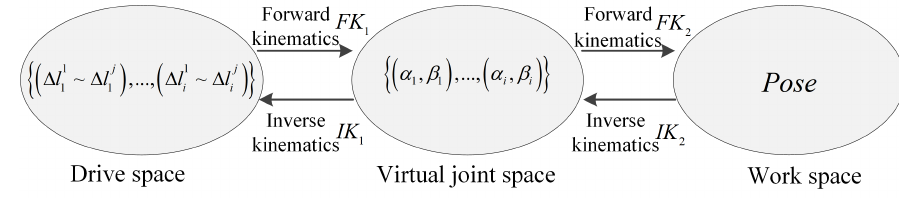
Figure 3. Kinematic relation.